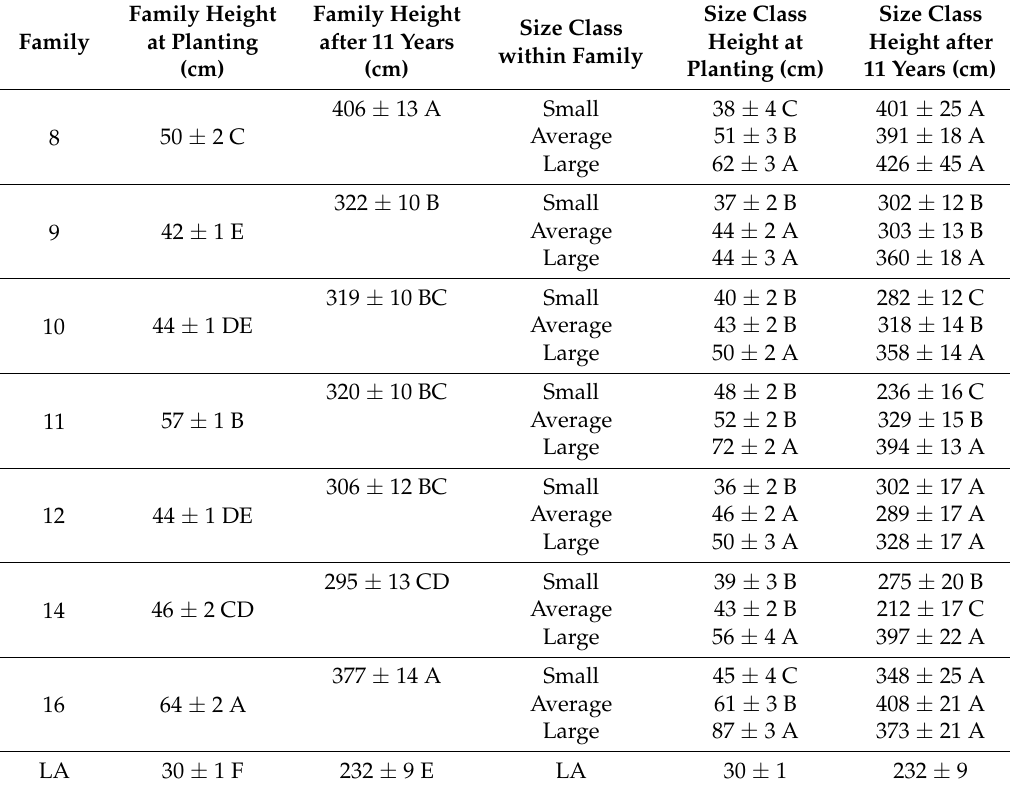
Table 1. Mean height ( ± standard error) of families and seedling size classes within family at planting and eleven years after planting. LA indicates locally available seedlings. Means among families for family treatment and within family for size class (family) treatment with the same letters do not differ statistically ( α =